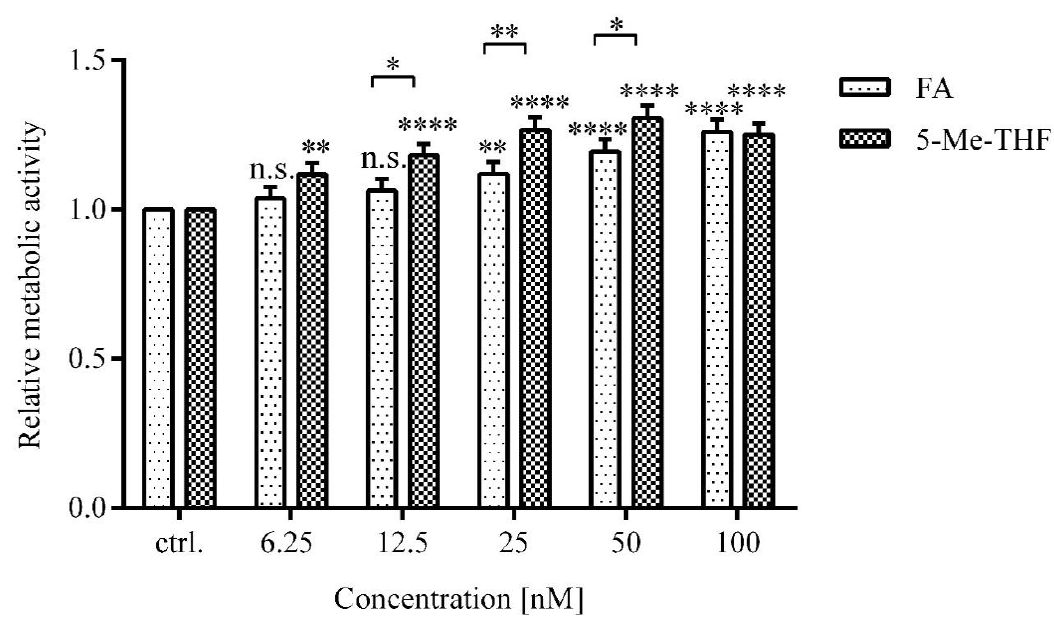
Figure 3. Concentration-dependent e ff ect of FA and 5-Me-THF on metabolic activity of LCLs. Folate-deprived LCLs ( n = 35) were incubated with five di ff erent concentrations of FA and 5-Me-THF for 72 h. Metabolic activity was assessed by an MTS assay. The response is expressed as fold change over vehicle-treated control. DMSO ( < 0.01%) was the vehicle control for all FA additions and water was the vehicle control for all 5-Me-THF additions. Values are means ± SD. Statistical di ff erences were determined by two-way ANOVA with a post hoc Dunnett’s multiple comparisons test. n.s. (not significant) p > 0.05, * p ≤ 0.05, ** p < 0.01, **** p < 0.0001 compared to untreated